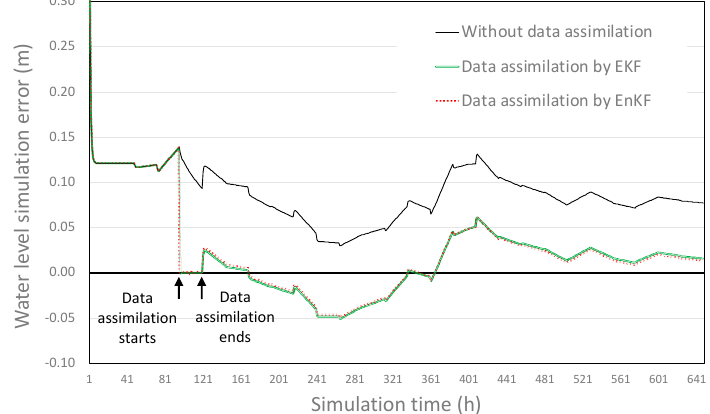
Table 7. Comparison of evaluation metrics for EKF and EnKF in Case 1.